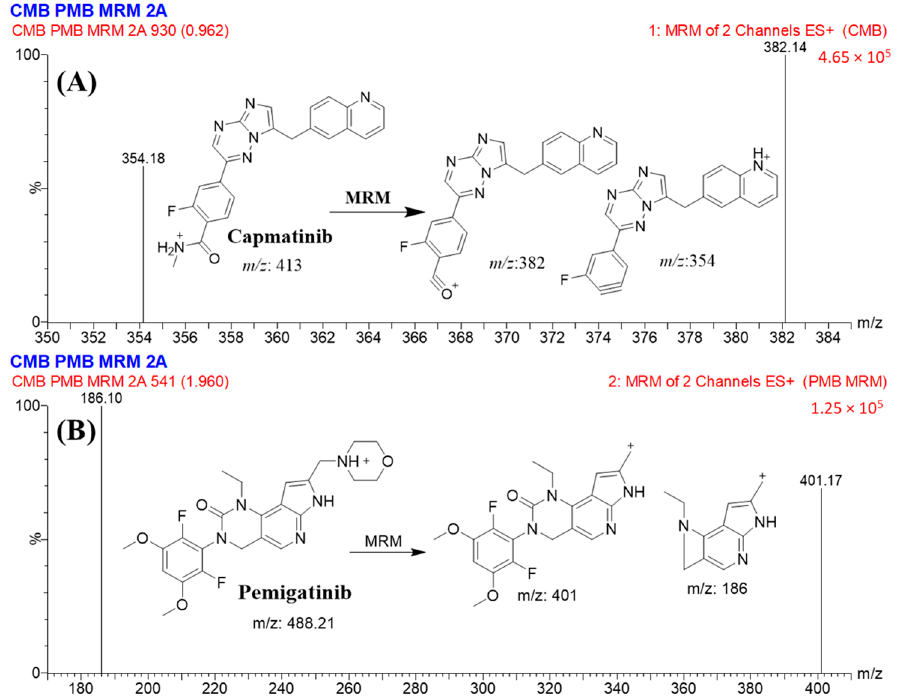
Figure 3. ( A ) MRM mass spectrum of capmatinib (CMB; [M + H] + ); ( B ) MRM mass spectrum of pemigatinib (PMT; [M + H] + ). The predicted fragmentation patterns are represented.